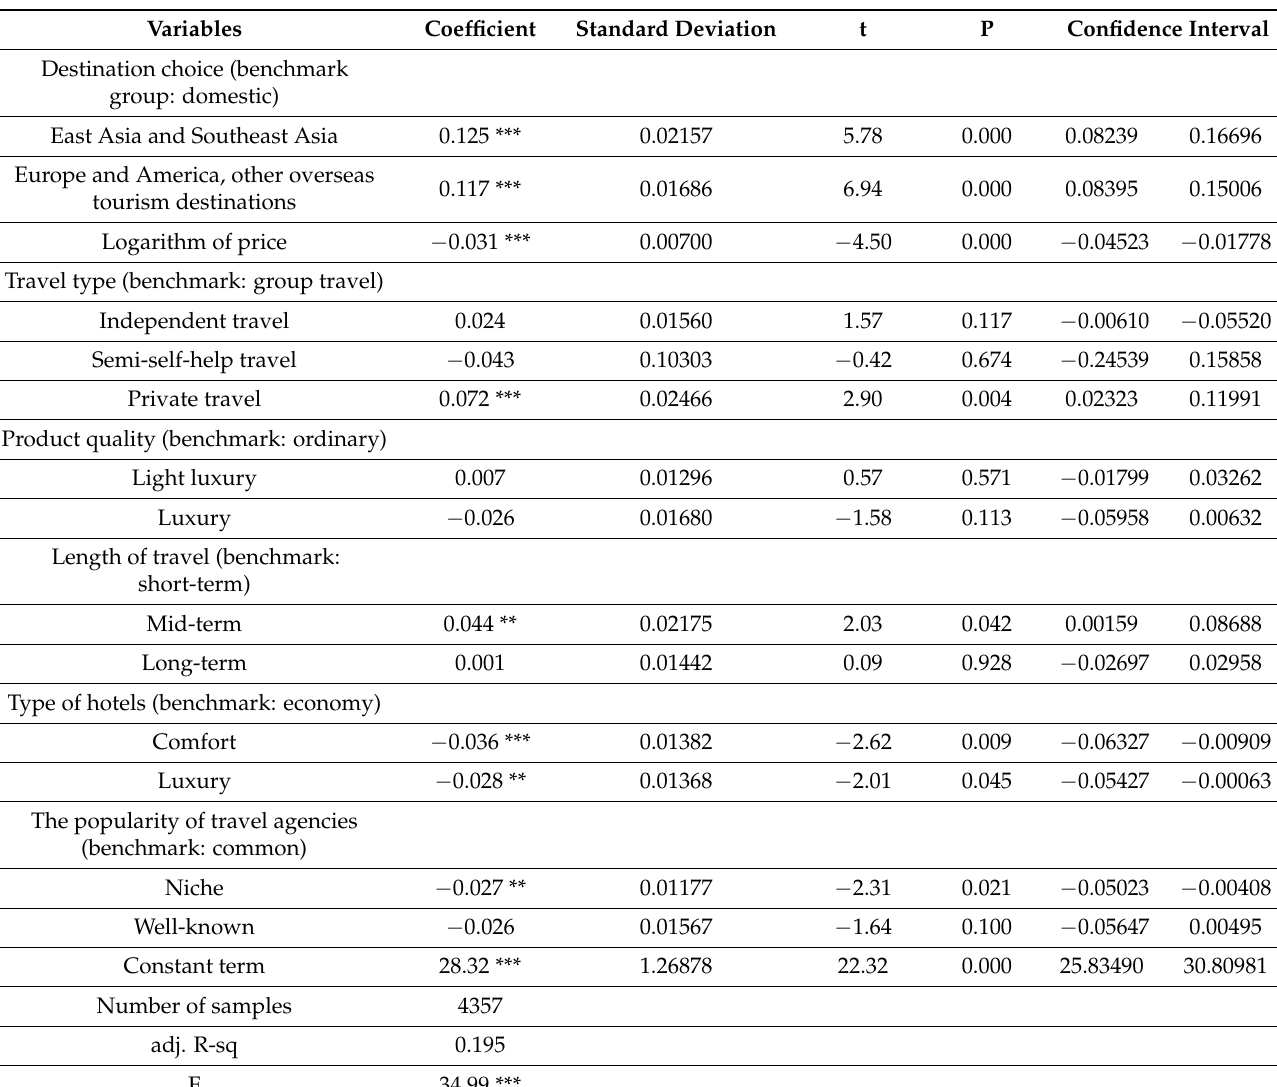
Table 2. The results of regression: the impact of tangible product characteristics of online itineraries on purchasing behavior. Variables Coefficient Standard Deviation t P Confidence Interval